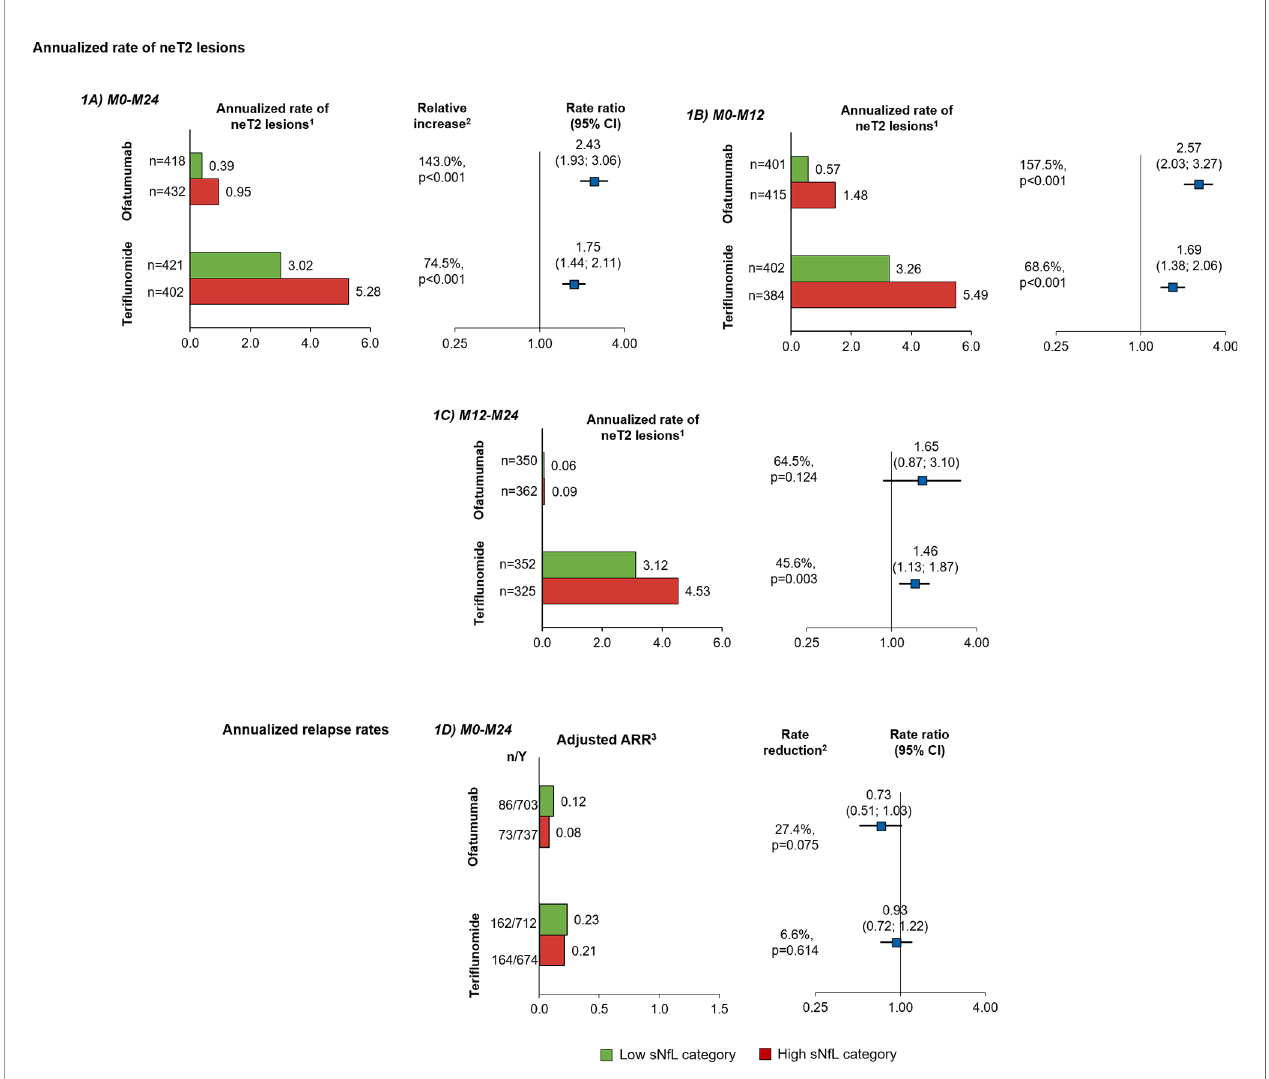
FIGURE 1 | Prognostic value of baseline sNfL [high (red), ≥ 9.3 pg/ml; low (green), <9.3 pg/ml] on measures of disease activity in the overall study population: annualized rate of neT2 lesions per year by baseline sNfL category in the interval (A) M0 – M24, (B) M0 – M12, and (C) M12 – M24; (D) ARR M0 – M24. Comparisons are between high vs. low sNfL categories. 1 Adjusted annualized mean rate of neT2 lesions. The number of neT2 lesions (compared to baseline or month 12) was analyzed in a negative binomial model with adjustments for treatment, baseline sNfL category, region and study as factors, and age and baseline volume of T2 lesions as continuous covariates, and treatment by baseline sNfL category interaction. The natural log of the time from the baseline scan (in years) was used as the offset. 2 Indicates statistical signi fi cance (two-sided) at the 0.05 level. 3 The ARR was analyzed in a negative binomial regression model with log-link to the number of relapses adjusted for treatment, baseline sNfL category, region and study as factors, number of relapses in previous year, baseline EDSS, baseline number of Gd+T1 lesions, and the patient ’ s age at baseline as covariates and treatment by baseline sNfL category interaction. The natural log of the time in study was used as offset to annualize the relapse rate. ARR, annualized relapse rate; CI, con fi dence interval; Gd+ gadolinium-enhancing; n, total number of relapses included in the analysis; neT2, new or enlarging T2 lesions; sNfL, serum neuro fi lament light; Y, number of patient-years in